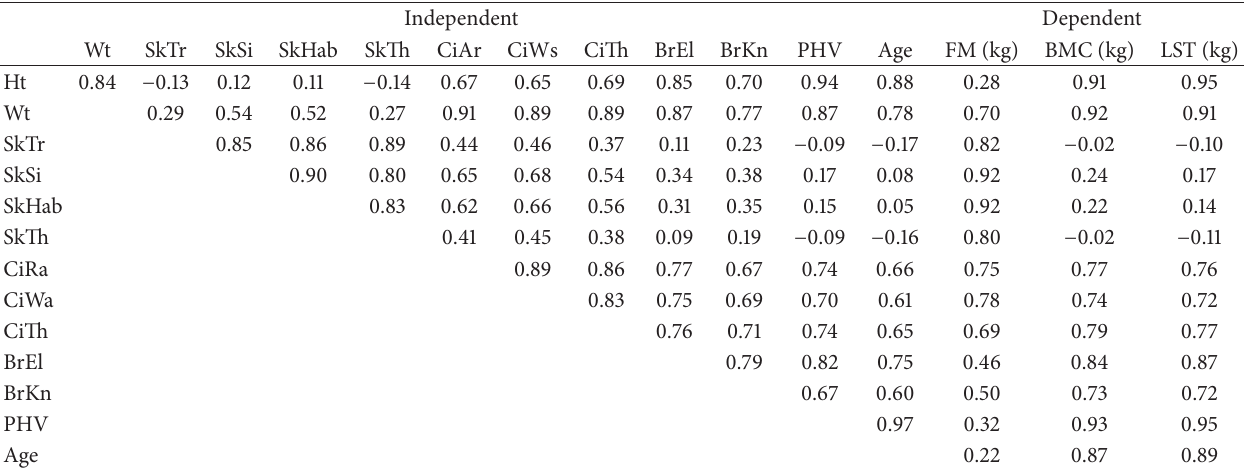
Table 2: Correlation matrix between independent and dependent variables in the pediatric population.